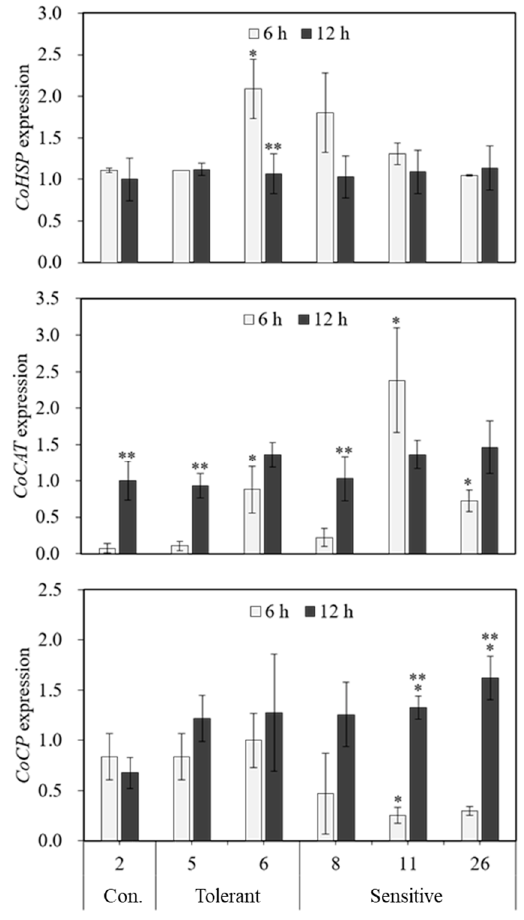
Figure 6. Effect of high-temperature treatment (32.5 °C) on the expression of heat stress-responsive genes ( CoHSP , CoCP , and CoCAT ) in Cnidium officinale heat-sensitive and heat-tolerant clones. CoActin gene was used as the reference gene. Asterisks represent significant differences at p < 0.05 ( n = 3, * vs. clone 2, ** vs. 0 h).